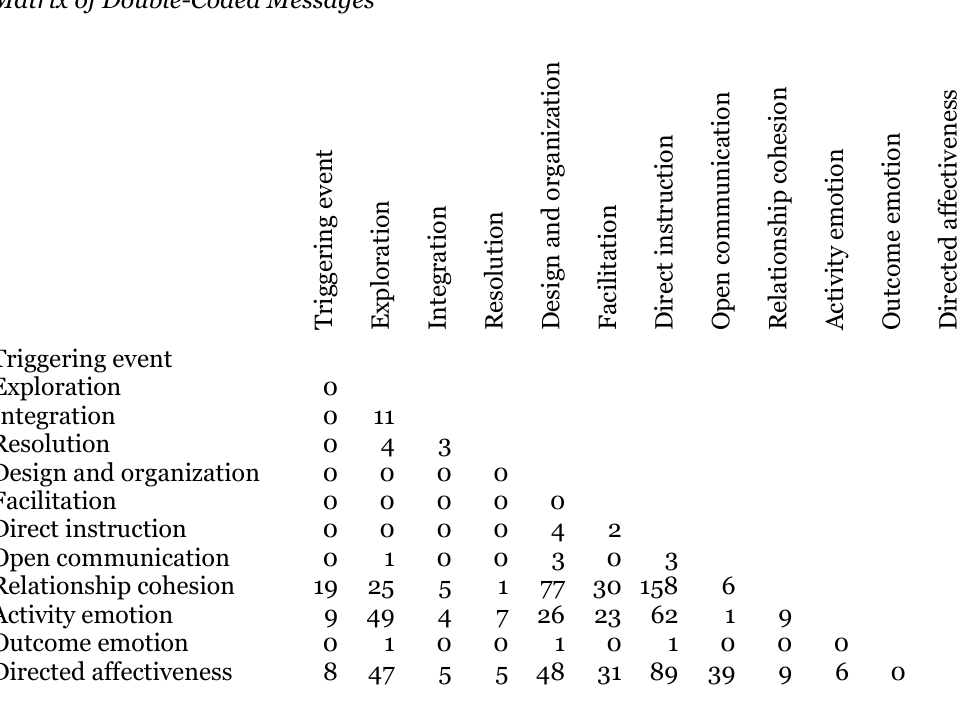
Matrix of Double-Coded Messages